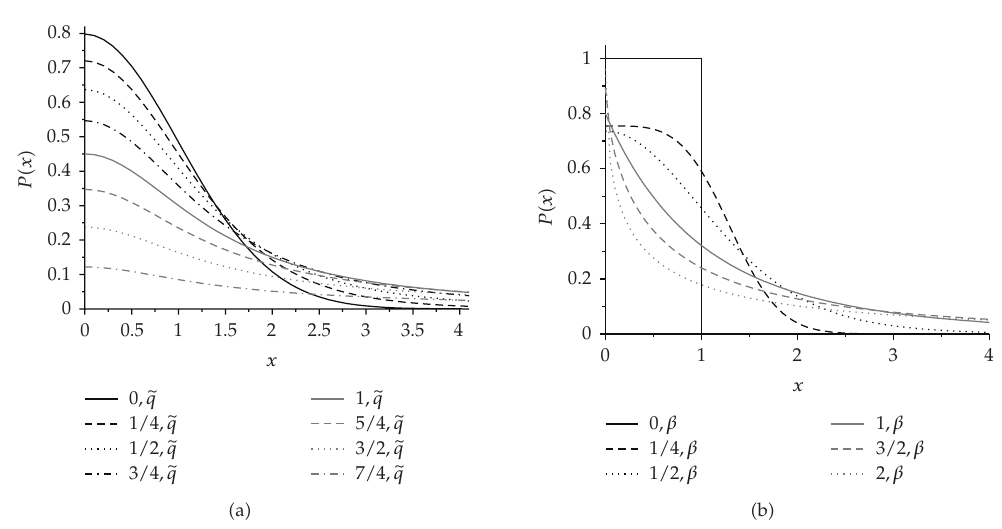
Figure 2: Behavior of (cid:2) 5.3 (cid:3) as a function of (cid:2) a (cid:3) x with β (cid:7) 1 / 2 and a (cid:7) 1 and for several (cid:2) q values (cid:2) projection of Figure 1 (cid:2) a (cid:3)(cid:3) , (cid:2) b (cid:3) x with (cid:2) q (cid:7) 1 / 5 and a (cid:7) 1 and for several β values (cid:2) projection of Figure 1 (cid:2) b (cid:3)(cid:3) .